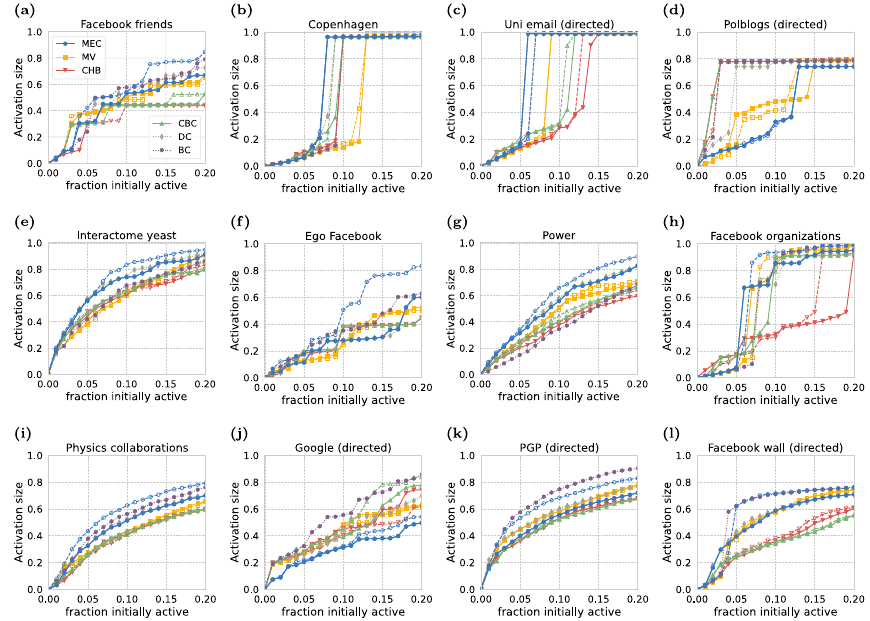
Fig. 5 Activation size for map equation centrality (MEC), modularity vitality (MV), community hub-bridge (CHB), community-based centrality (CBC), degree centrality (DC), and betweenness centrality (BC) in twelve empirical networks under the linear threshold model with threshold t = 0.5 . Community structures are identified with Infomap; solid lines use the unrecorded link teleportation flow model, dashed lines use recorded node